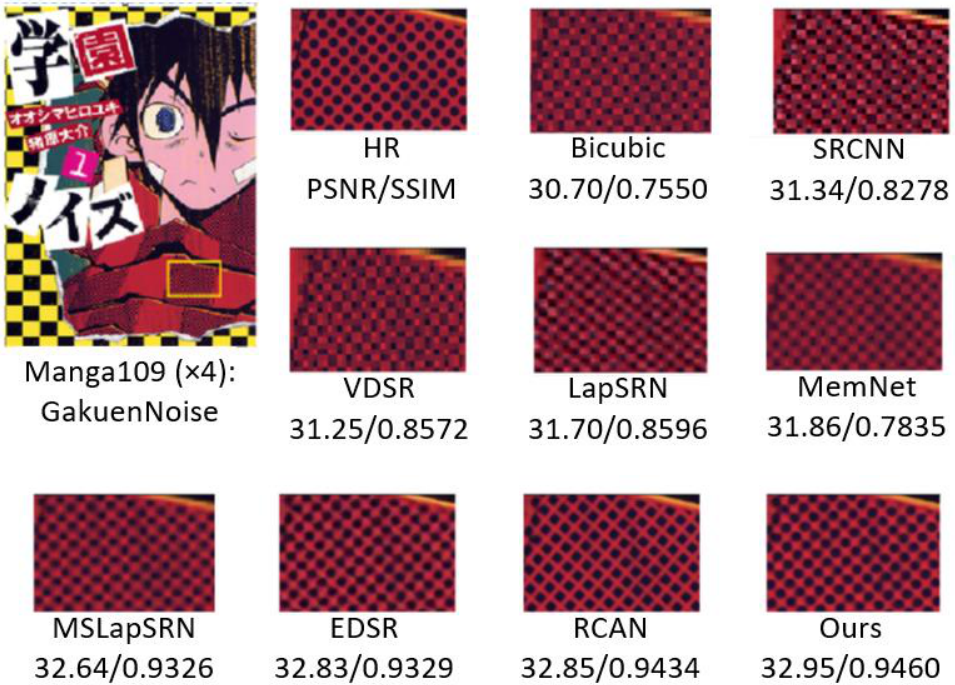
Figure 12. Visual comparison of image “GakuenNoise” at × 4 scale on the Manga109 dataset.